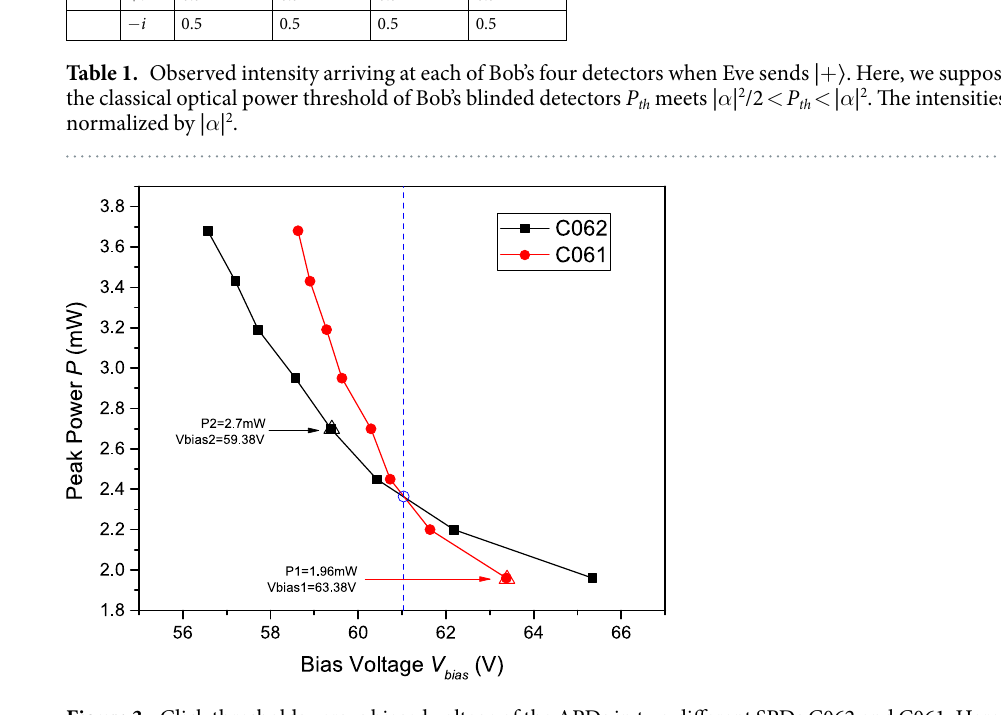
Step 3 - Reducing the double-click rate. To reduce the usual double-click rate, in our attack, we apply an intrinsic imperfection of SPDs that real single-photon detectors respond differently to the same blinding power. As shown in Fig. 3 (see Methods section for the detailed measurement setup), for a particular biased voltage of avalanche pho- todiodes (APDs) Vbias in two different SPDs, the click thresholds are different. In the original blinding attack, the blinding is caused by the drop of the bias voltage such that the APD operates in the linear mode. Hence, in our meas- urement, we directly change the bias voltage of the APDs in the two SPDs and record corresponding click thresholds. Especially, with the increase in Vbias, the click threshold curves for the two detectors cross (see the dashed line in Fig. 3). Before the dashed line, the threshold of detector C062 is less than that of detector C061; however, after the dashed line, the threshold of detector C062 is larger than that of detector C061. Hence, Eve can simply choose a combination of P and Vbias before (after) the dashed line, such that a click occurs only on detector C062 (C061) and no click occurs on detector C061 (C062). By doing this, Eve can easily reduce the usual double-click rate. To demon- strate the feasibility of our attack, we control the two detectors with two different combinations of P and Vbias. The results are shown in Fig. 4. The values P 1 = 1.96 mW and V bias 1 = 63.38 V cause a detection event in detector C061, however, never cause it in detector C062. In contrast, the values P 2 = 2.7 mW and V bias 2 = 59.38 V cause a detection